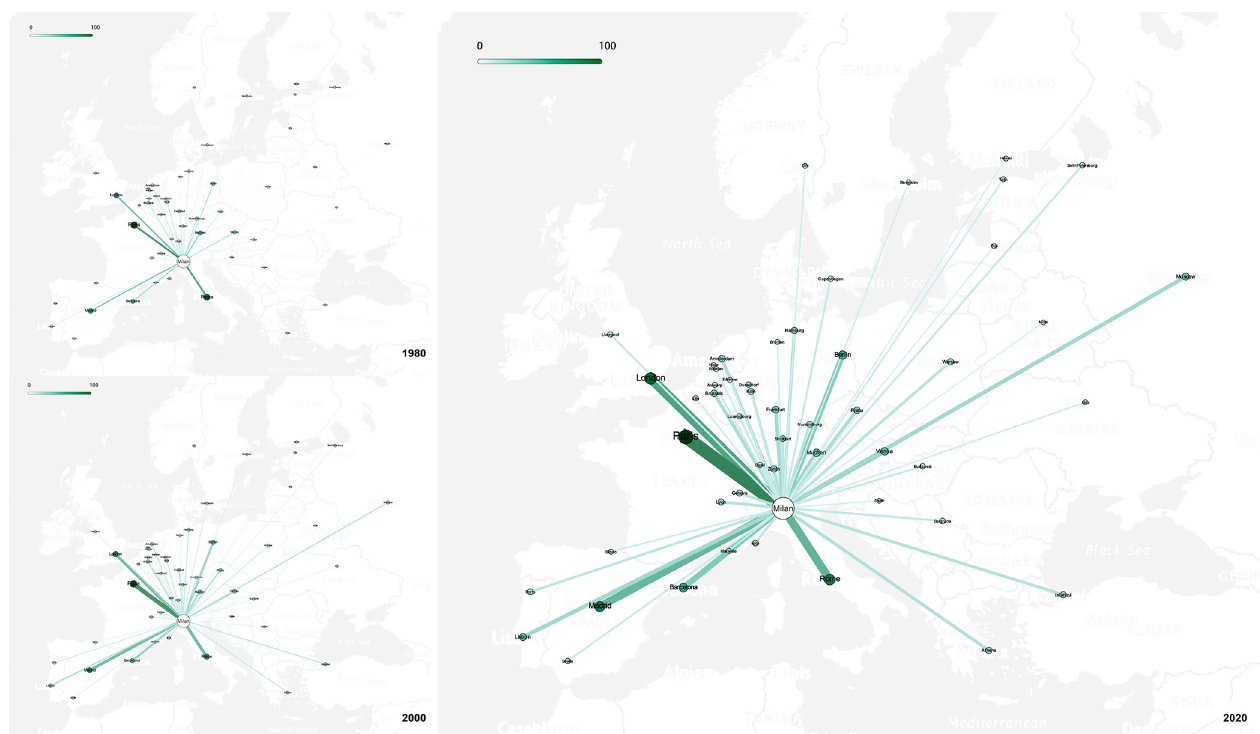
Fig 4. Outward interlock between Milan and other cities. (Base map source: USGS National Map Viewer (public domain)).